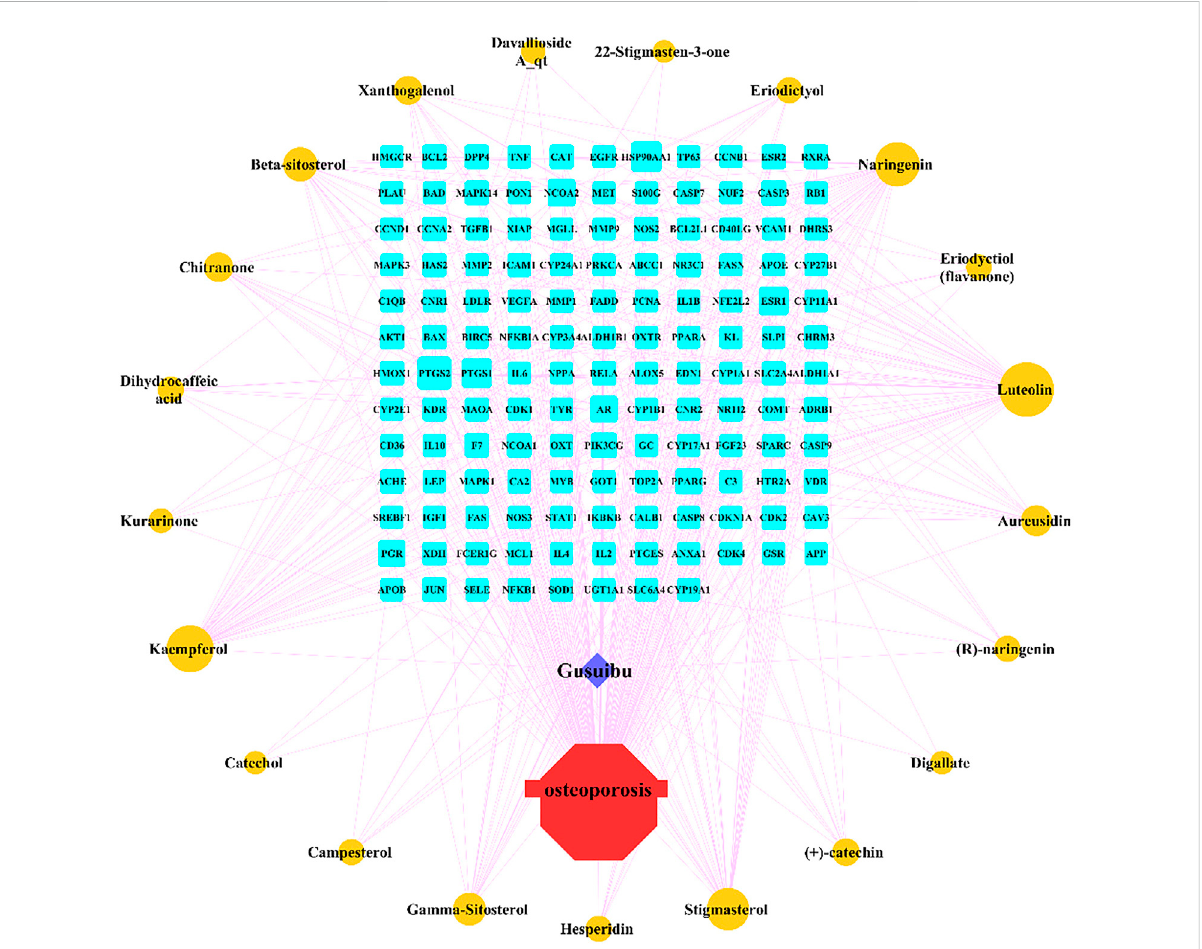
FIGURE 2 “ Gusuibu-active compounds-target genes-osteoporosis ” network. The red octagon represents osteoporosis; the blue diamond represents Gusuibu; the cyan rectangle represents the potential target; the brown ellipse represents the active compound contained in Gusuibu. The line between two nodes indicates that there is a relationship, and the size of each node indicates the number of